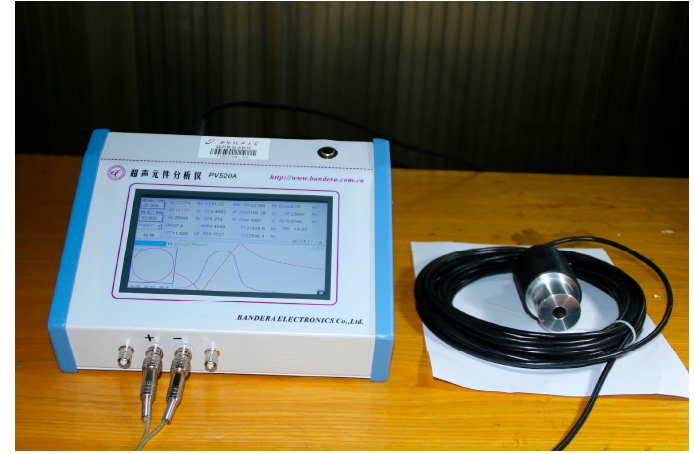
Figure 10. The impedance test of the sandwiched ultrasonic transducer.